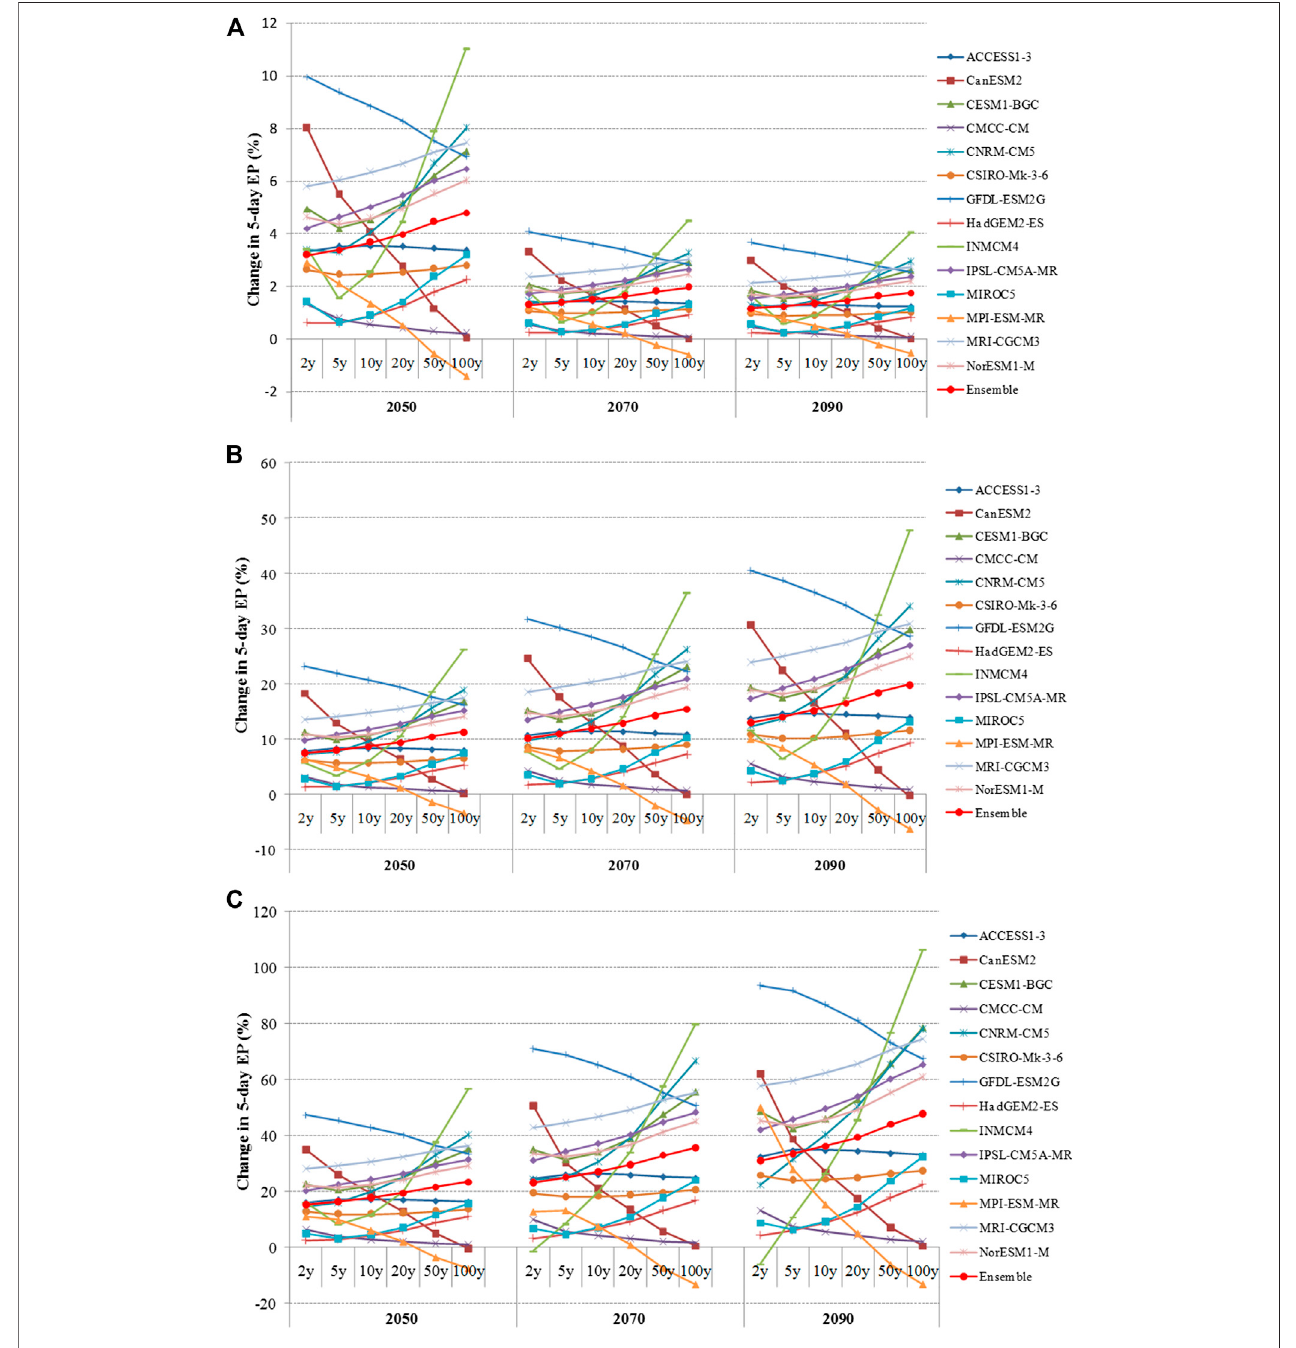
FIGURE4| Changein5-dayextreme precipitation under14GCMsandtheirensembleatVinhStationcorrespondingtoRCP2.6 (A) ,RCP6.0 (B) ,andRCP8.5 (C) .